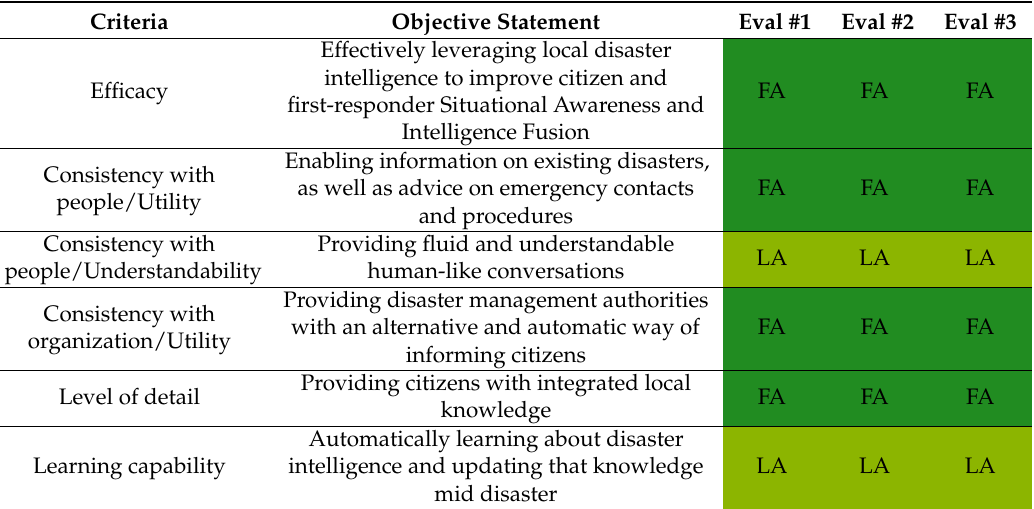
Table 9. Results of the third DSRM